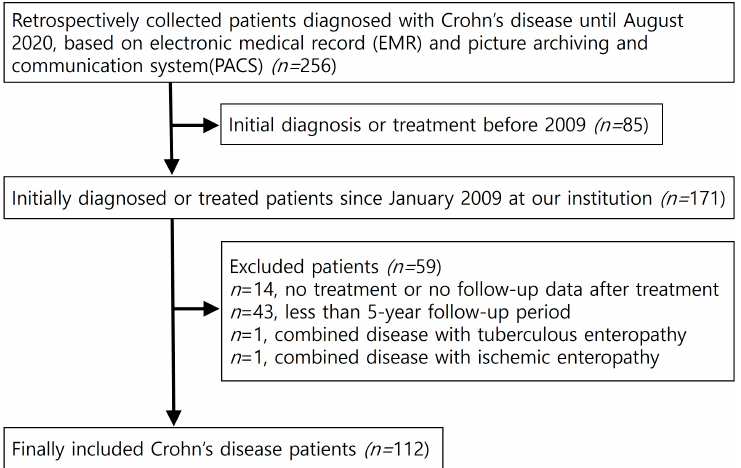
Figure 1. Flow chart of patient selection.